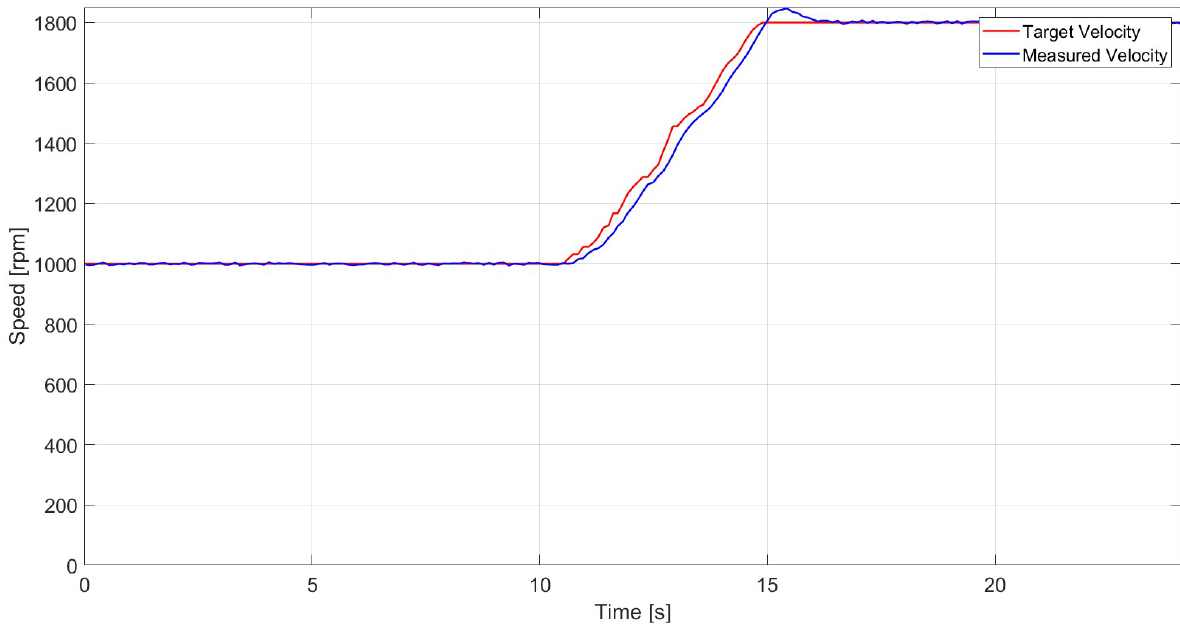
Figure 28. Speed command and measurement for the field weakening operation